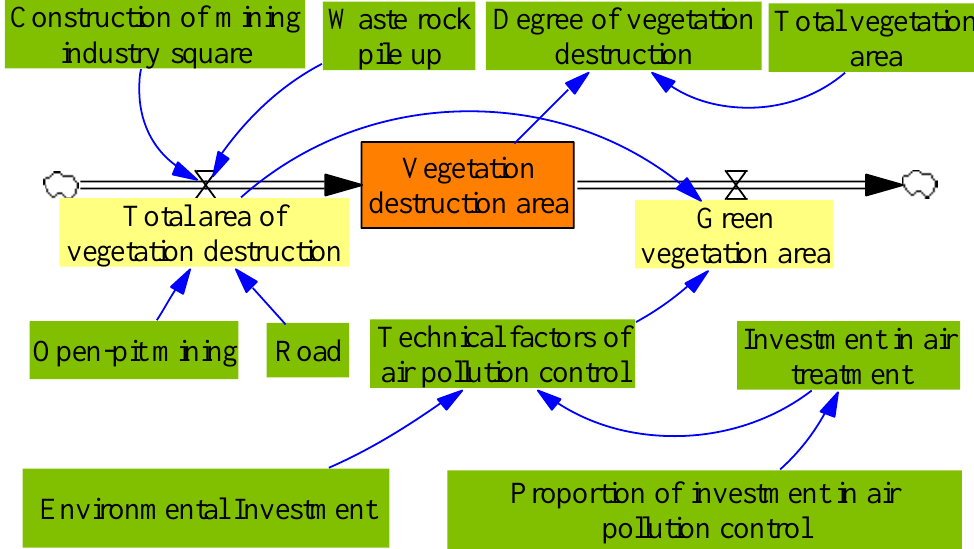
Figure 5. The system flow diagram of water resource subsystem.